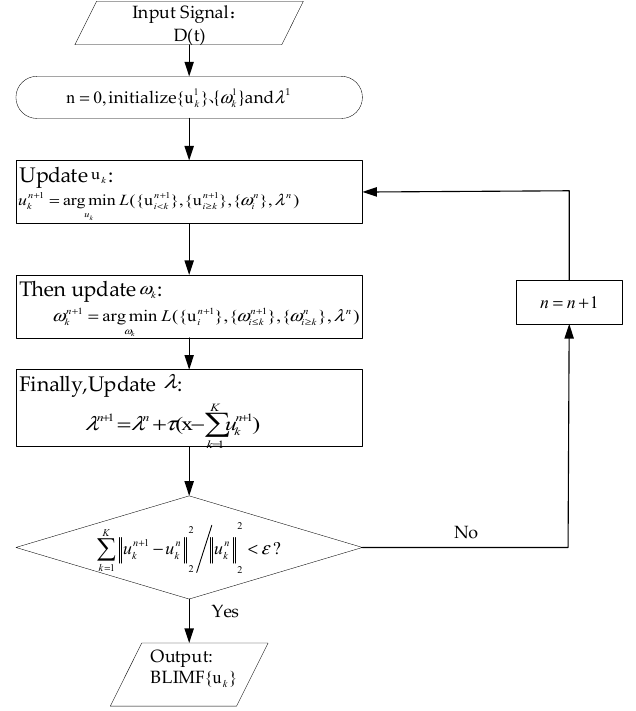
Figure 2. The alternating direction method of multipliers (ADMM) algorithm flowchart.